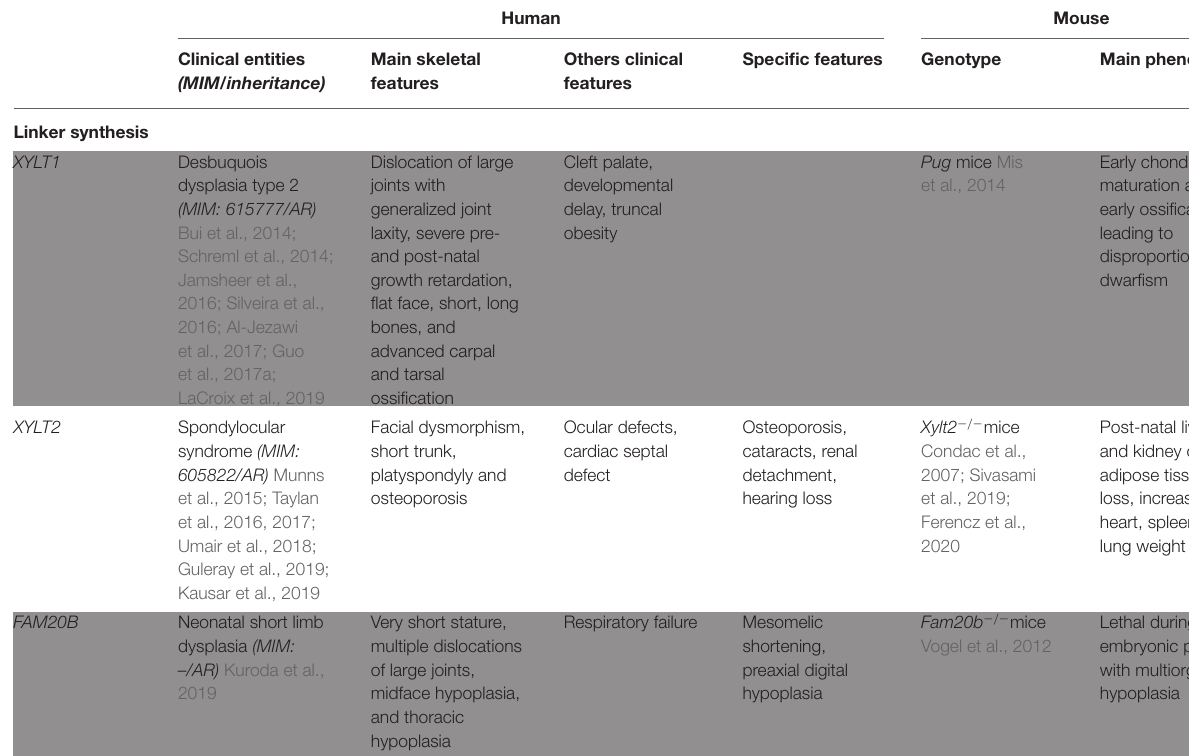
TABLE 1 | Skeletal dysplasias caused by defects in GAG biosynthesis and related animal models.